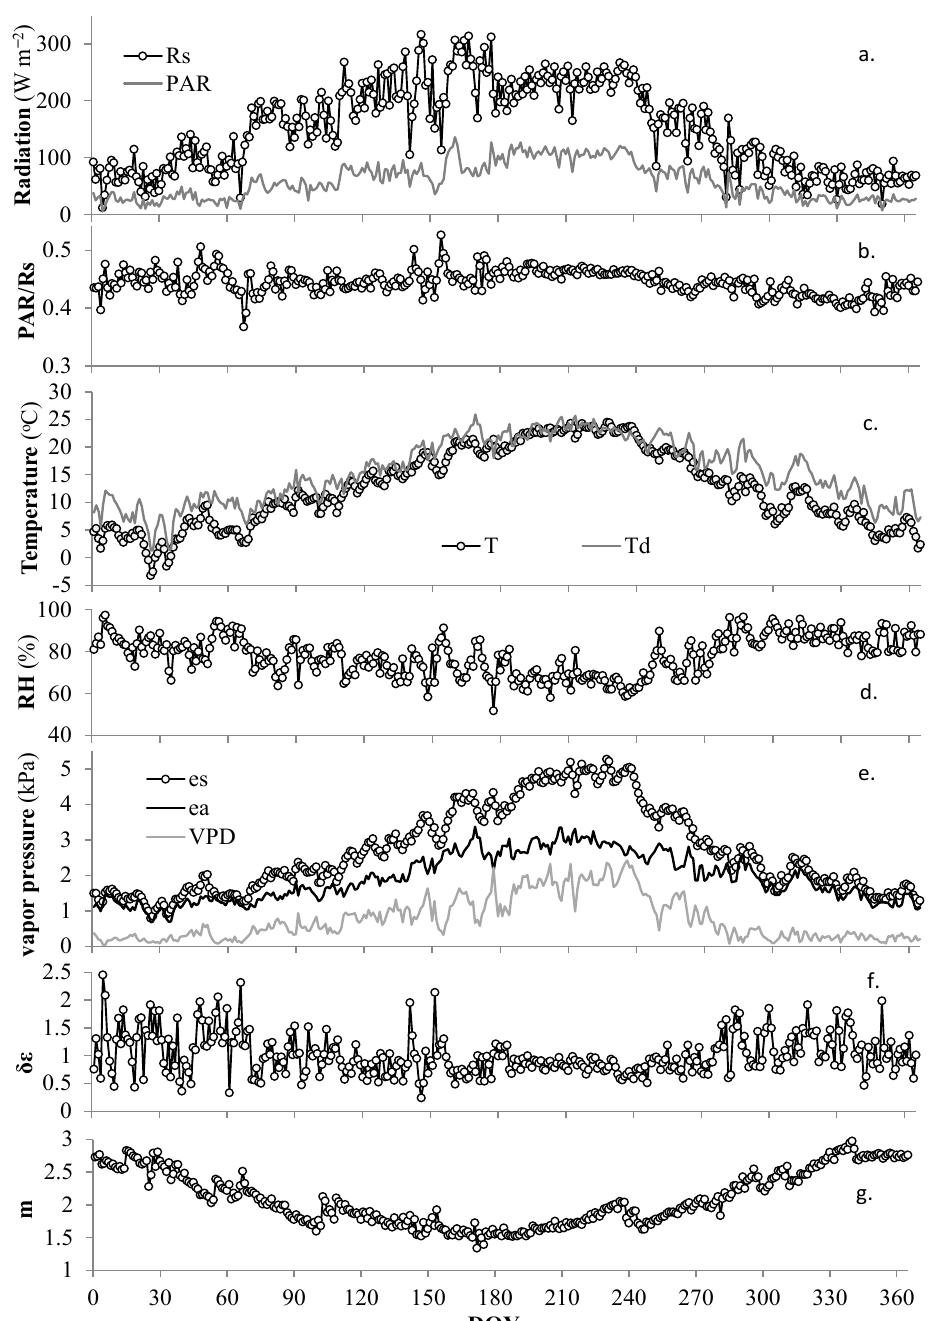
Figure 2. Mean of the period 2009–2014 daily variations of ( a ) global solar Rs and photosynthetically active PAR radiation fluxes, ( b ) PAR/Rs ratio, ( c ) air T and dewpoint T d temperatures, ( d ) relative humidity RH, ( e ) saturation e s , actual e s vapor pressure values and vapor pressure deficit VPD, ( f ) optical thickness δ ( ε ), and ( g ) relative optical air mass m.